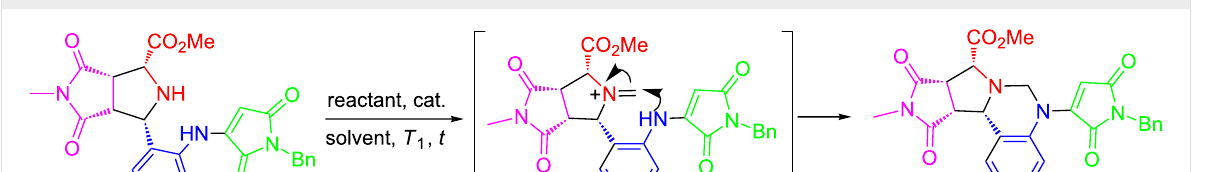
Table 2: Optimization of [5 + 1] annulation for product 1a a